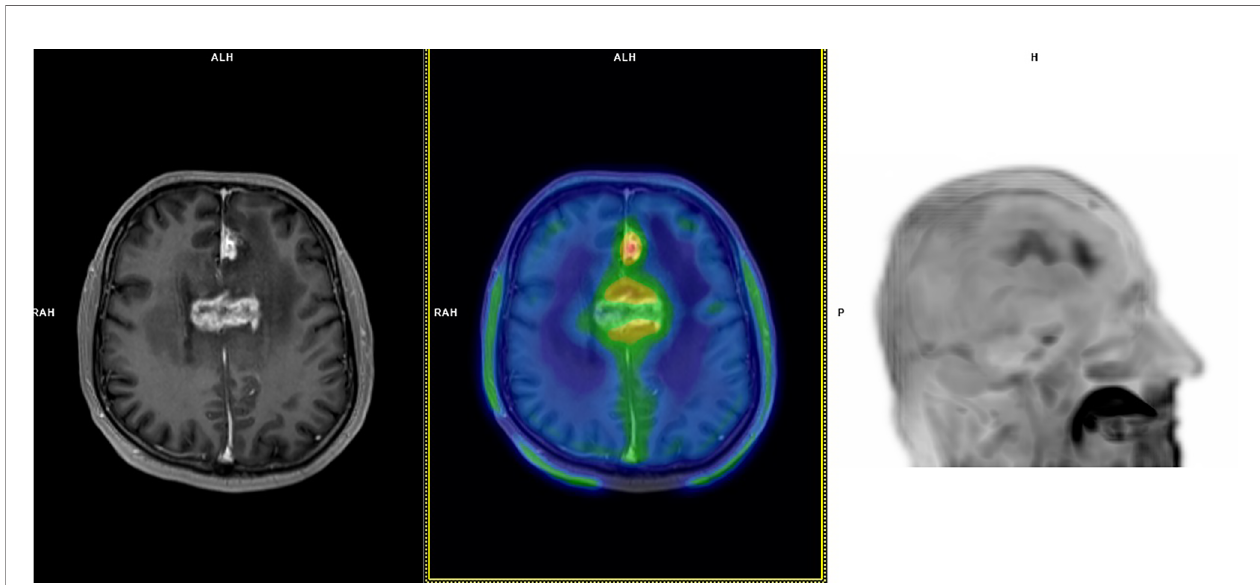
FIGURE 2 | A 60-year-old patient with bioptic diagnosis of astrocytoma WHO grade 3 with lesions in the left frontal lobe and corpus callosum (IDH wild-type; MGMT methylated) treated with chemoradiation (completed in March 2018) and re-irradiation in July 2018. Follow-up MRI scans in October 2018 documented an increasing T2/FLAIR signal and irregular contrast-enhancement at the medial aspect of the left frontal lobe and corpus callosum; no diffusion restriction was seen, and perfusion weighted imaging demonstrated slight increase in Ktrans e Ve values without abnormal Vp. MRI appearances were deemed dubious for GR, favouring the hypothesis of TICs. 18 F-FET PET performed in November 2018 demonstrated focal tracer uptake at late static imaging (TBRmax: 3.4), a TAC pattern with a TTP at 20 min and subsequent plateau (TAC pattern 2). 18 F-FET PET was considered suggestive of GR. MRI performed in January 2019 documented GR, and chemotherapy was started. This patient died in July 2019 (PFS: 1 month; OS: 8 months).